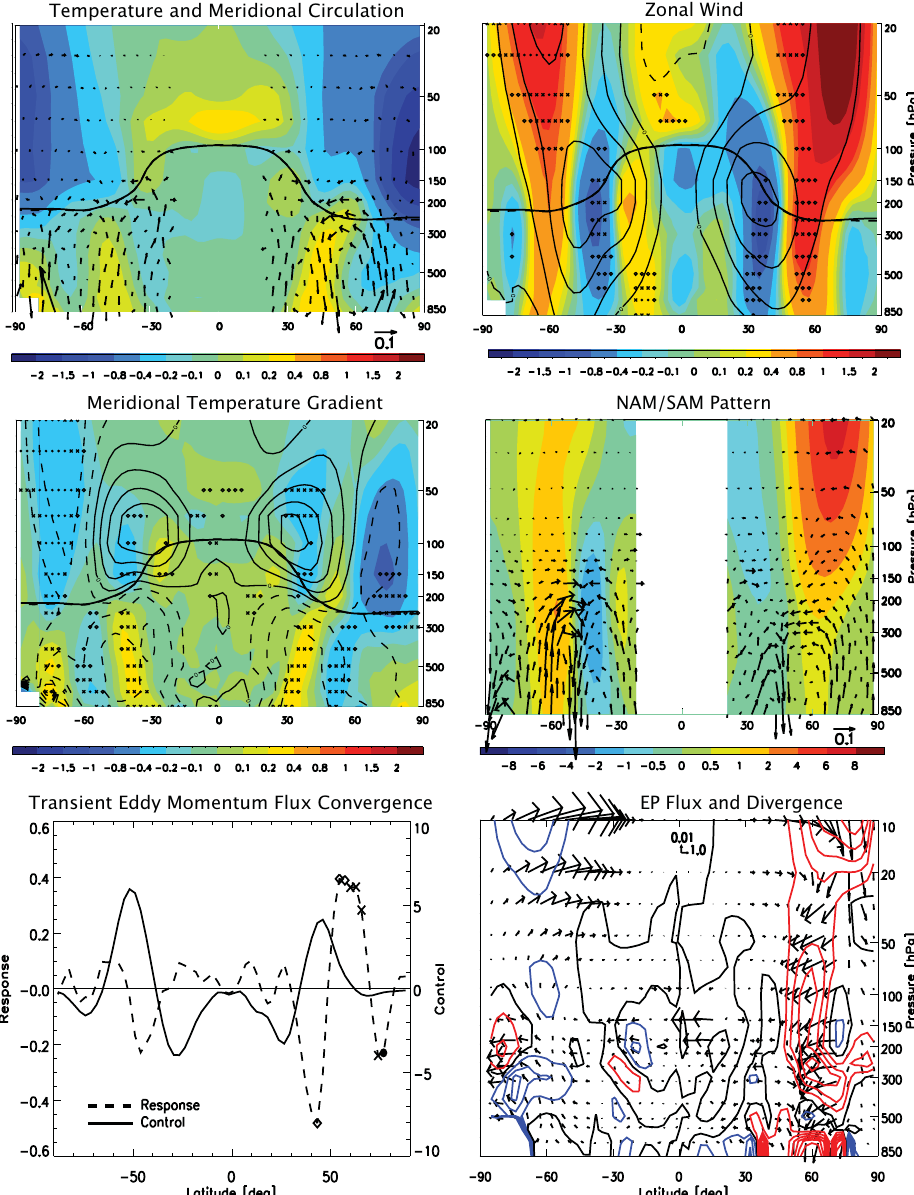
Fig. 9. MAM 10PLO3 HL response of (top left) temperature and meridional circulation, (top right) zonal wind, (middle left) meridional temperature gradient, (middle right) SAM/NAM U pattern, (bottom left) 250hPa transient eddy momentum flux convergence [K m s − 1 ] and (bottom right) EP flux [m 2 s − 2 ] and flux divergence [10 − 6 m s − 2 ], divided by the standard density. T y ( U ) contour interval is 2 × 10 − 3 K km − 1 (10 m s − 1 ) with negative values dashed. Units of NAM/SAM are m s − 1 per standard deviation of the PC time series. Indicated vector length (top left) represents 0.1 cm s − 1 for the meridional component and − 0 . 1 × 10 − 4 Pa s − 1 for the vertical component. EP flux divergence contour interval is [ − 6, − 5, − 4, − 3, − 2, − 1, 0, 1, 2, 3, 4, 5, 6], with negative values blue and positive values red. Symbols represent significance as in Fig. 2. Transient eddy momentum flux, u 0 v 0 is estimated according to uv − ¯ u ¯ v , where primes denote zonal deviations and overbars indicate zonal